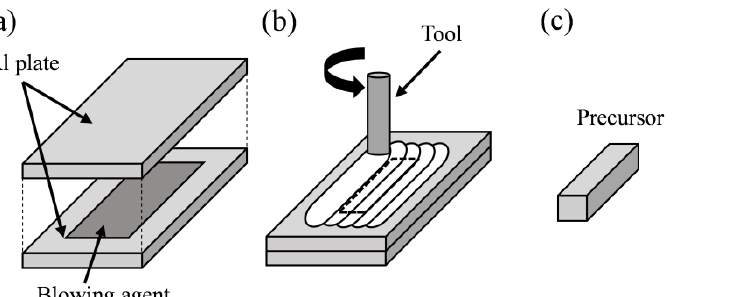
Figure 1. FSW process for fabrication of porous Al precursor (adapted from [13]). ( a ) Blowing agent powder was spread between the Al plates and laminated. ( b ) Blowing agent was distributed into the Al plates by FSW. ( c ) Precursor of porous Al was obtained.